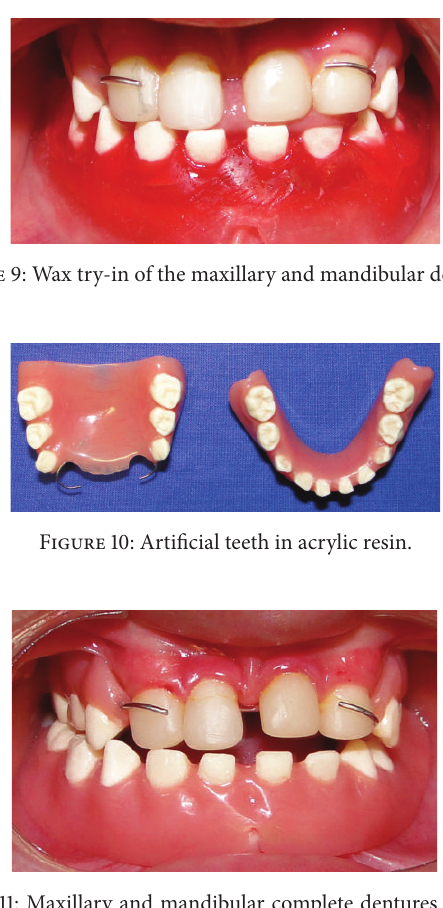
Figure 11: Maxillary and mandibular complete dentures in occlu-